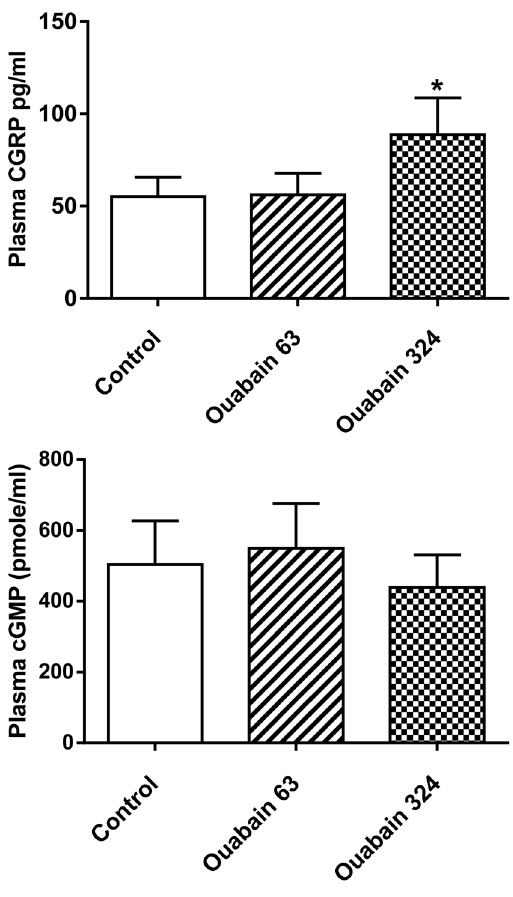
Figure 8. Effect of ouabain on the plasma levels of CGRP and cGMP. The data are presented as the means (SDs); n=10. Control, rats with implanted placebo pellets; Ouabain 63, rats treated for 40 days with 63 m g ouabain/kg/day, Ouabain 324, rats treated for 40 days with 63 m g ouabain/kg/day and then for 40 days with 324 m g ouabain/kg/ day. The statistical analysis was performed with one-way ANOVA and Tukey’s post hoc multiple comparison test; CGRP: F 2,27 =17, P=17.10 2 6 ; *P Tukey’s =18.10 2 5 vs. control; cGMP: F 2,27 =1.192, P=0.319).